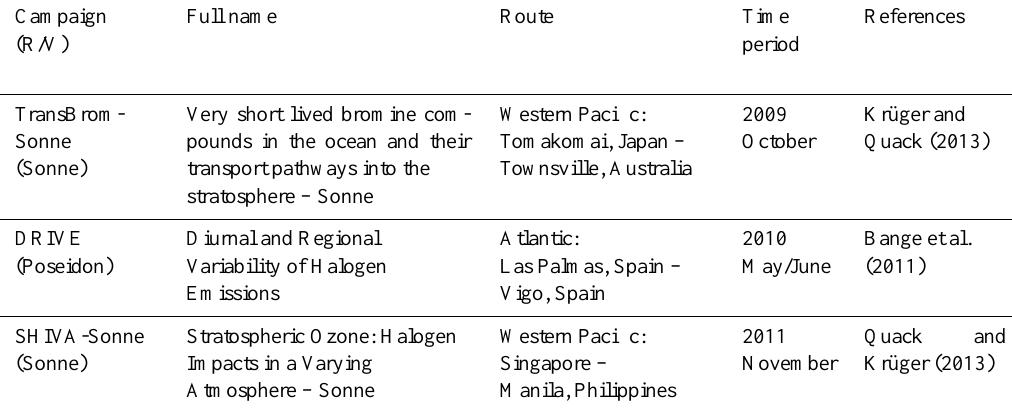
Table 2. Recent ship campaigns providing oceanic and atmospheric CH 3 I measurements.